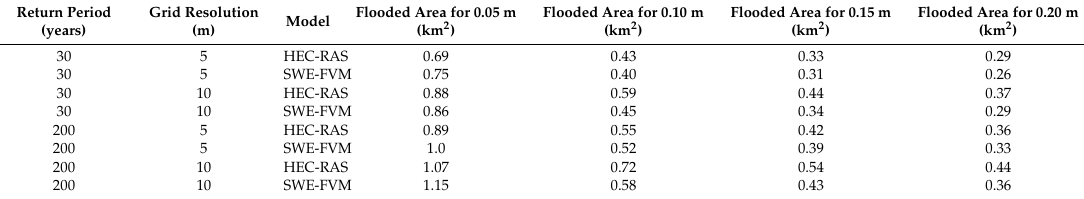
Table 3. Flooded areas for a given water depth: comparison between the